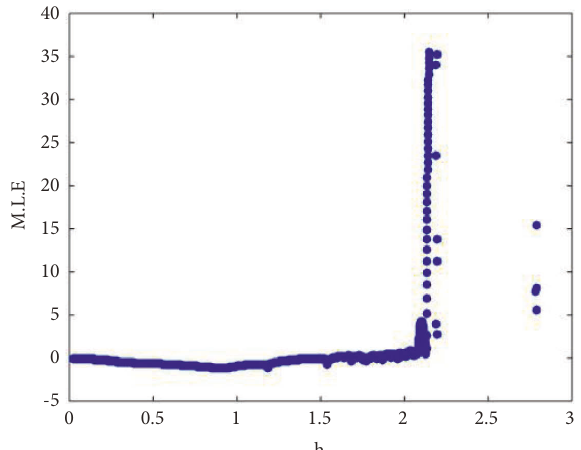
Figure 8: M. L. E corresponding to Figure 7 of the Brusselator system (10).